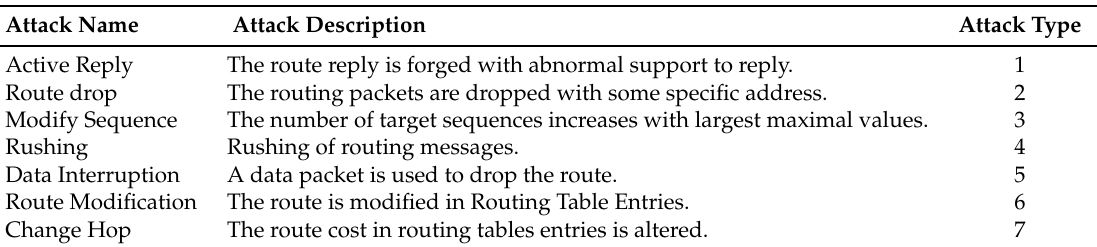
Table 4. Basic attacker types with packet routing protocols on the ad hoc on-demand distance vector (AODV) protocol in wireless sensor networks (WSNs).